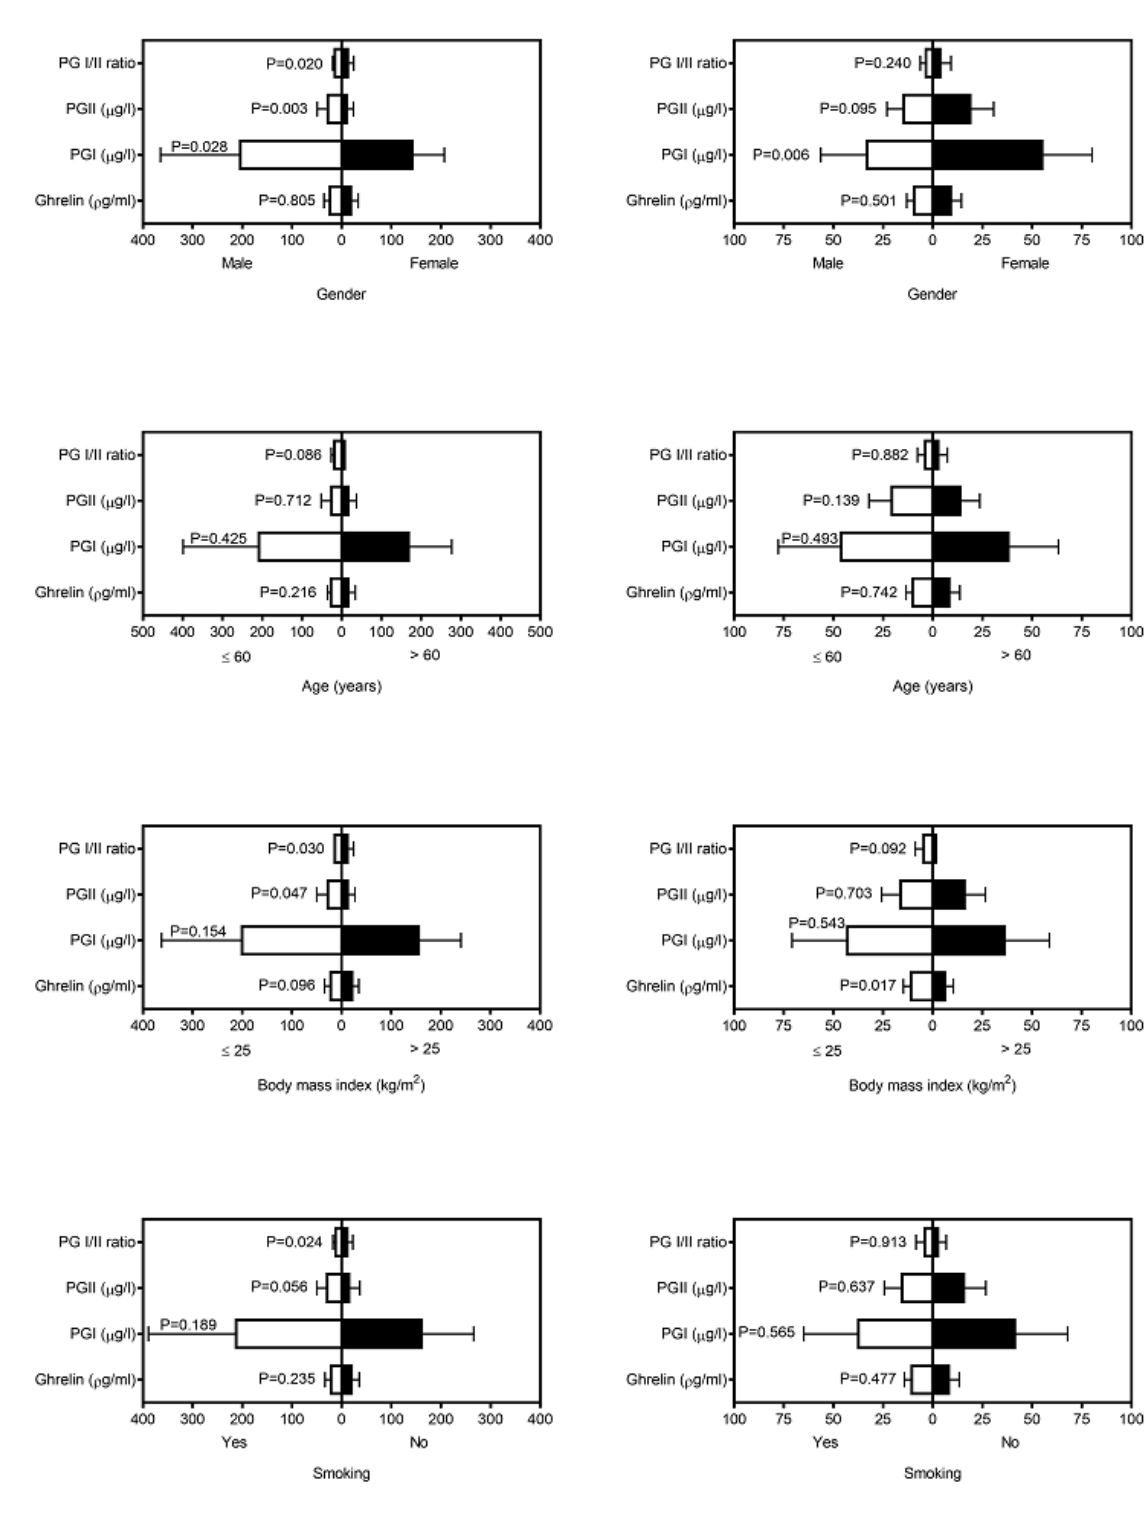
Figure 2: Serum levels of ghrelin, pepsinogen I, II, and their ratio based on sex, age, BMI, and smoking categories. Left bar, control group; right bar, gastric cancer group. Data are considered as standard deviation (Means ±